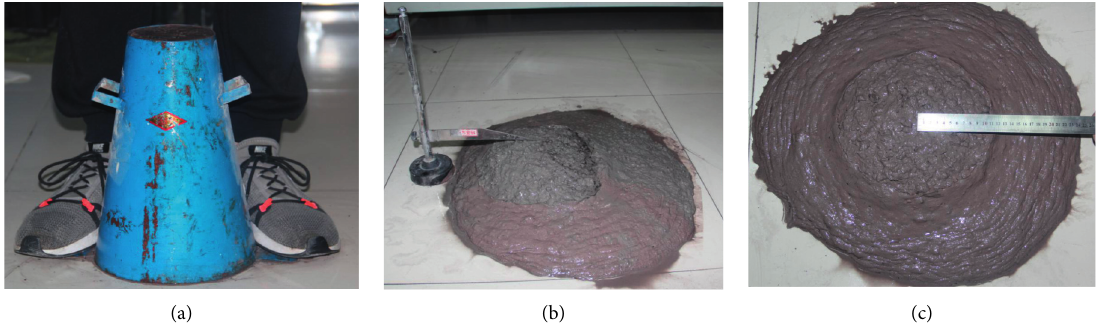
Figure 2: Slump test configuration.